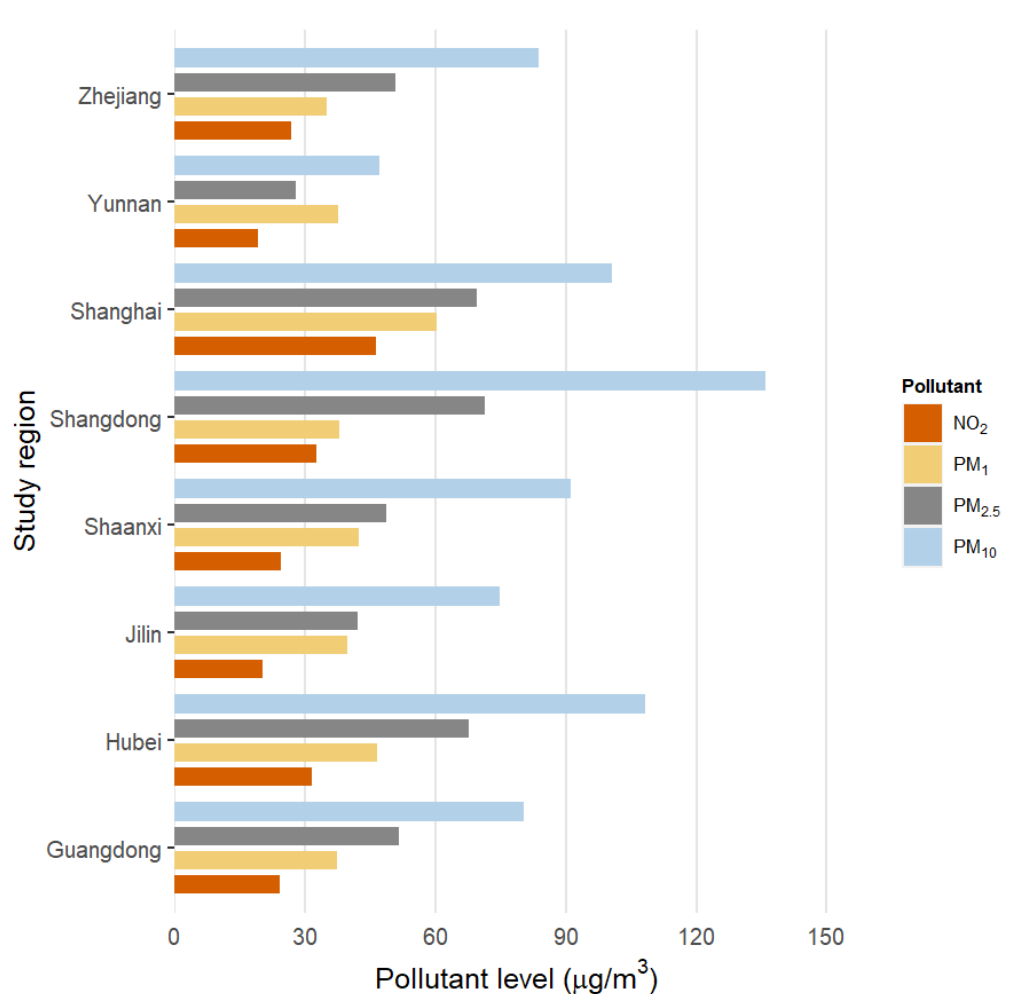
Figure 1. Distributions of 3-year average concentrations of air pollutants in study on global aging and adult health (SAGE) China study